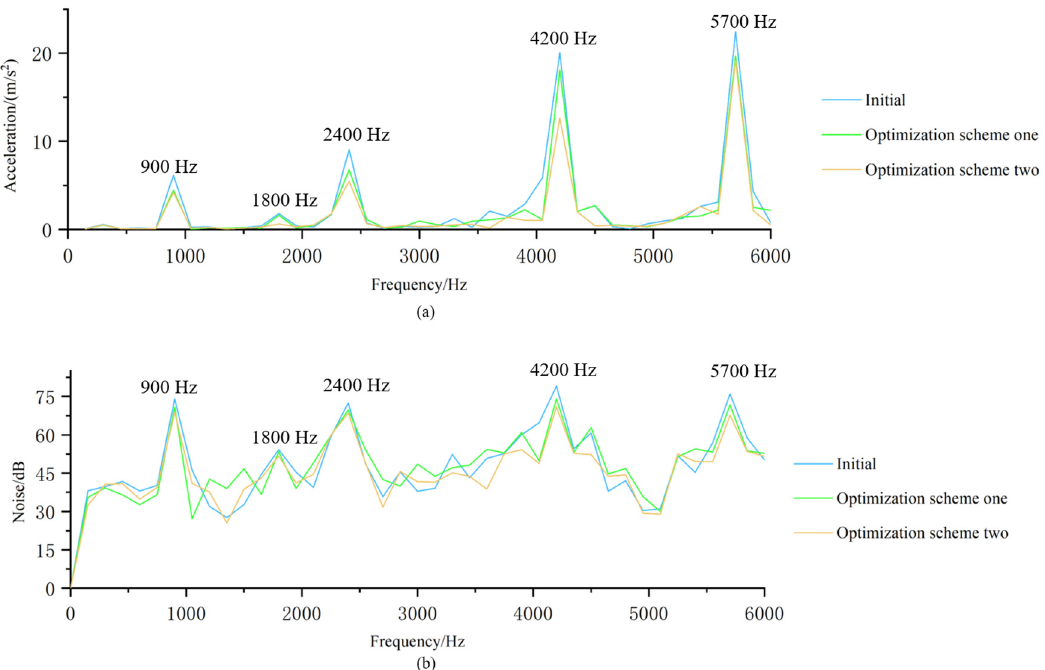
Figure 10. ( a ) Vibration acceleration at a point on the stator surface; ( b ) noise at a point in the air domain. Table 4. Vibration acceleration amplitude at major frequency points.